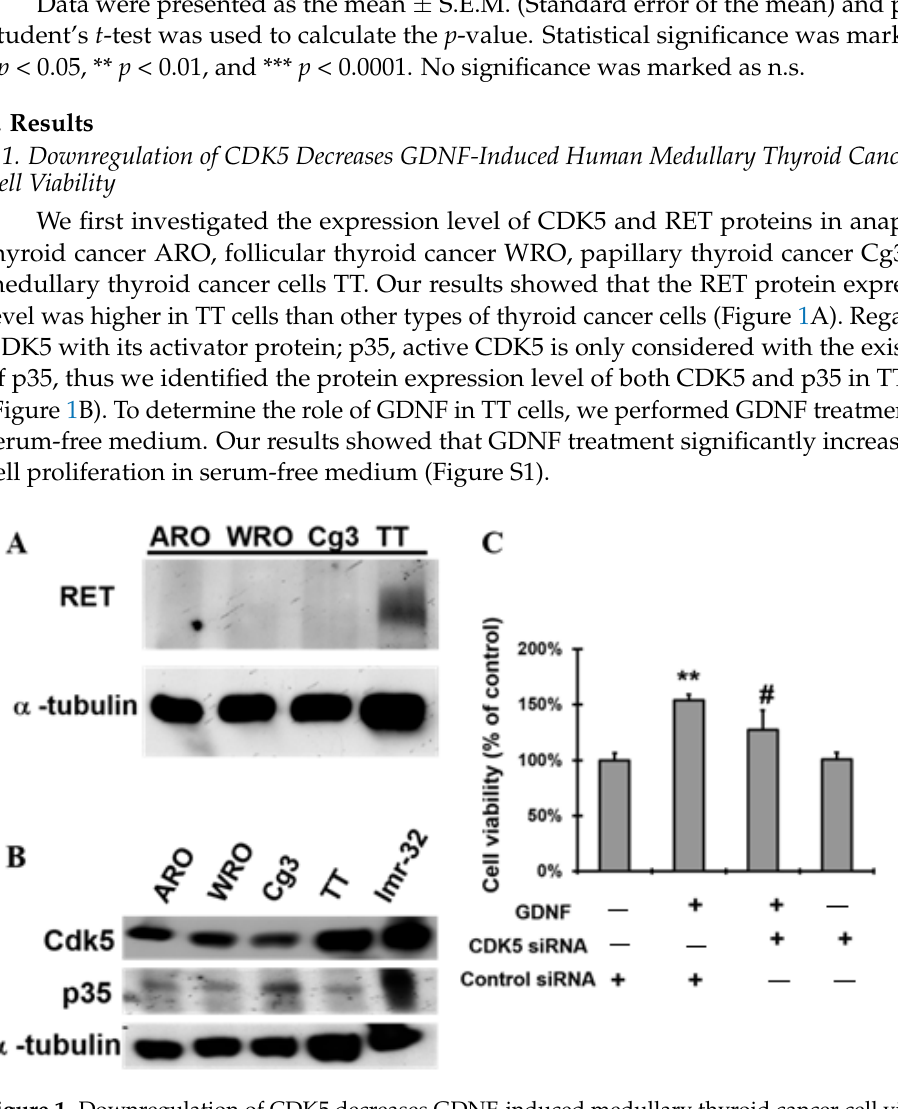
Figure 1. Downregulation of CDK5 decreases GDNF-induced medullary thyroid cancer cell viability in TT cells. ( A ) Protein expression level of RET in anaplastic thyroid cancer ARO, follicular thyroid cancer WRO, papillary thyroid cancer Cg3 and medullary thyroid cancer cells TT. ( B ) Protein expression level of CDK5 and p35 in ARO, WRO, Cg3, TT and Imr-32. Imr-32 (human neuroblastoma cell line) serves as a positive control for CDK5 and p35 protein, since their expression are higher in Imr-32 cells. ( C ) Cell viability of TT cells in the presence of GDNF with nonspecific control siRNA, GDNF + CDK5 siRNA, and CDK5 siRNA groups (GDNF: 200 ng/mL). Control group represents as absence of GDNF, and presence of nonspecific control siRNA. Cell viability was normalized to % of control. α -Tubulin was used as an internal control. ** p < 0.01, vs. control. # p < 0.05, vs. GDNF.